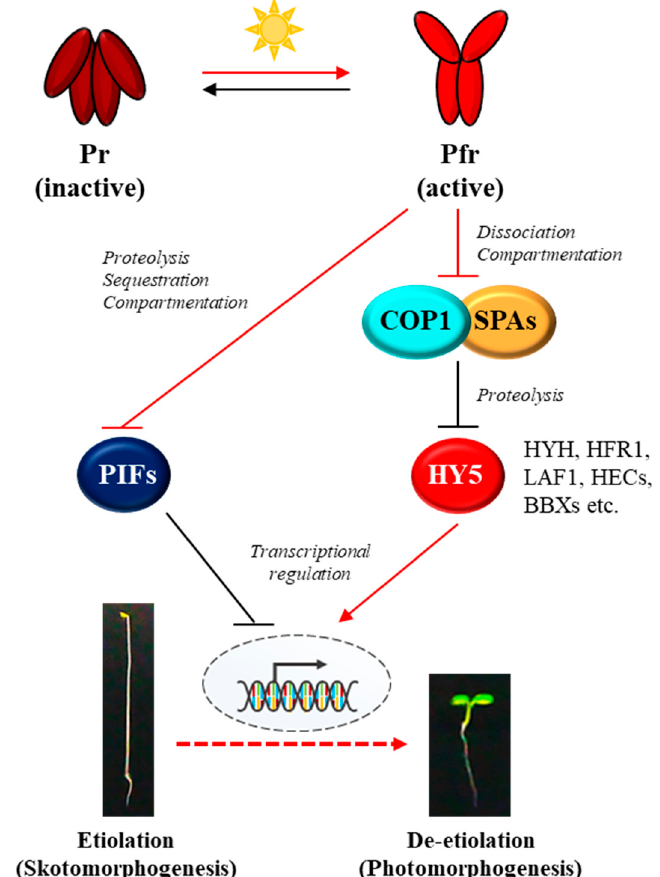
Figure 1. A simplified model of the core phytochrome signaling pathway for photomorphogenesis. Phytochromes are biosynthesized in the cytoplasm as the inactive Pr form in the dark. In the mean- time, two repressors for photomorphogenesis, PIFs and COP1/SPA complex promote and sustain skotomorphogenesis by negatively regulating transcriptional factors for photomorphogenesis such as HY5 via proteolysis. Upon exposure to light, the active Pfr form is generated and translocated from the cytoplasm to the nucleus. Then, the photoactivated phytochromes negatively regulate both the PIFs and the COP1/SPA complex. As the regulatory mechanisms for PIFs, phytochromes induce 26S proteasome-mediated degradation (i.e., proteolysis), inhibition of binding to the tar- get promoters (i.e., sequestration), and retention in the cytoplasm (i.e., compartmentation). At the same time, phytochromes induce the dissociation of COP1/SPA complex and the translocation of COP1 from the nucleus to the cytoplasm (i.e., compartmentation), which inactivate the E3-ligase activity of the complex on target proteins. As a result, HY5 is accumulated, which induces the expression of photoresponsive genes for photomorphogenesis. Red arrows and lines indicate the phytochrome-mediated light signaling, while black arrows and lines represent the regulation in the dark for skotomorphogenesis. Pr and Pfr, red and far-red light-absorbing forms of phytochromes; PIFs, phytochrome-interacting factors (8 PIFs in Arabidopsis); COP1, CONSTITUTIVELY PHOTO- MORPHOGENIC 1; SPAs, SUPPRESSORs OF phyA-105 (4 SPAs in Arabidopsis); HY5, ELONGATED HYPOCOTYL 5; HYH, HY5-HOMOLOG; HFR1, LONG HYPOCOTYL IN FAR-RED 1; LAF1, LONG AFTER FAR-RED LIGHT 1; HECs, HECATEs; BBXs, B-box